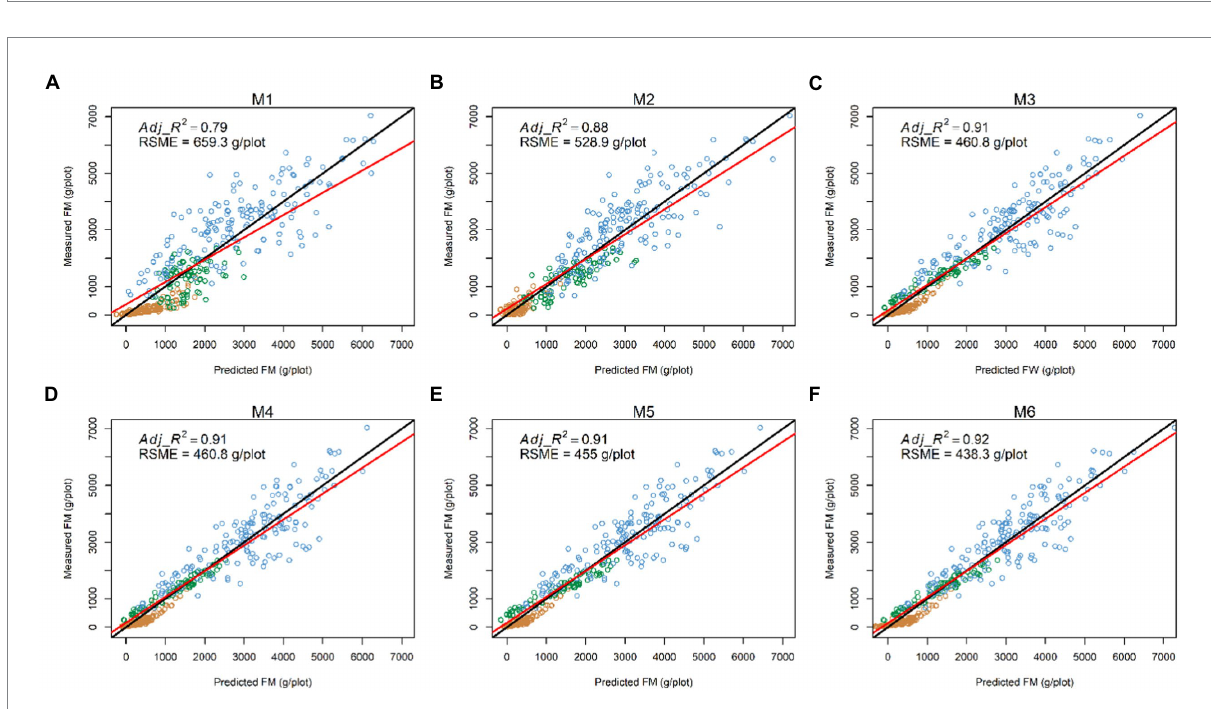
FIGURE 5 Comparisons between the measured and predicted fresh biomass (FM) at the plot level ( N = 386) in the combined dataset from six prediction models: (A)